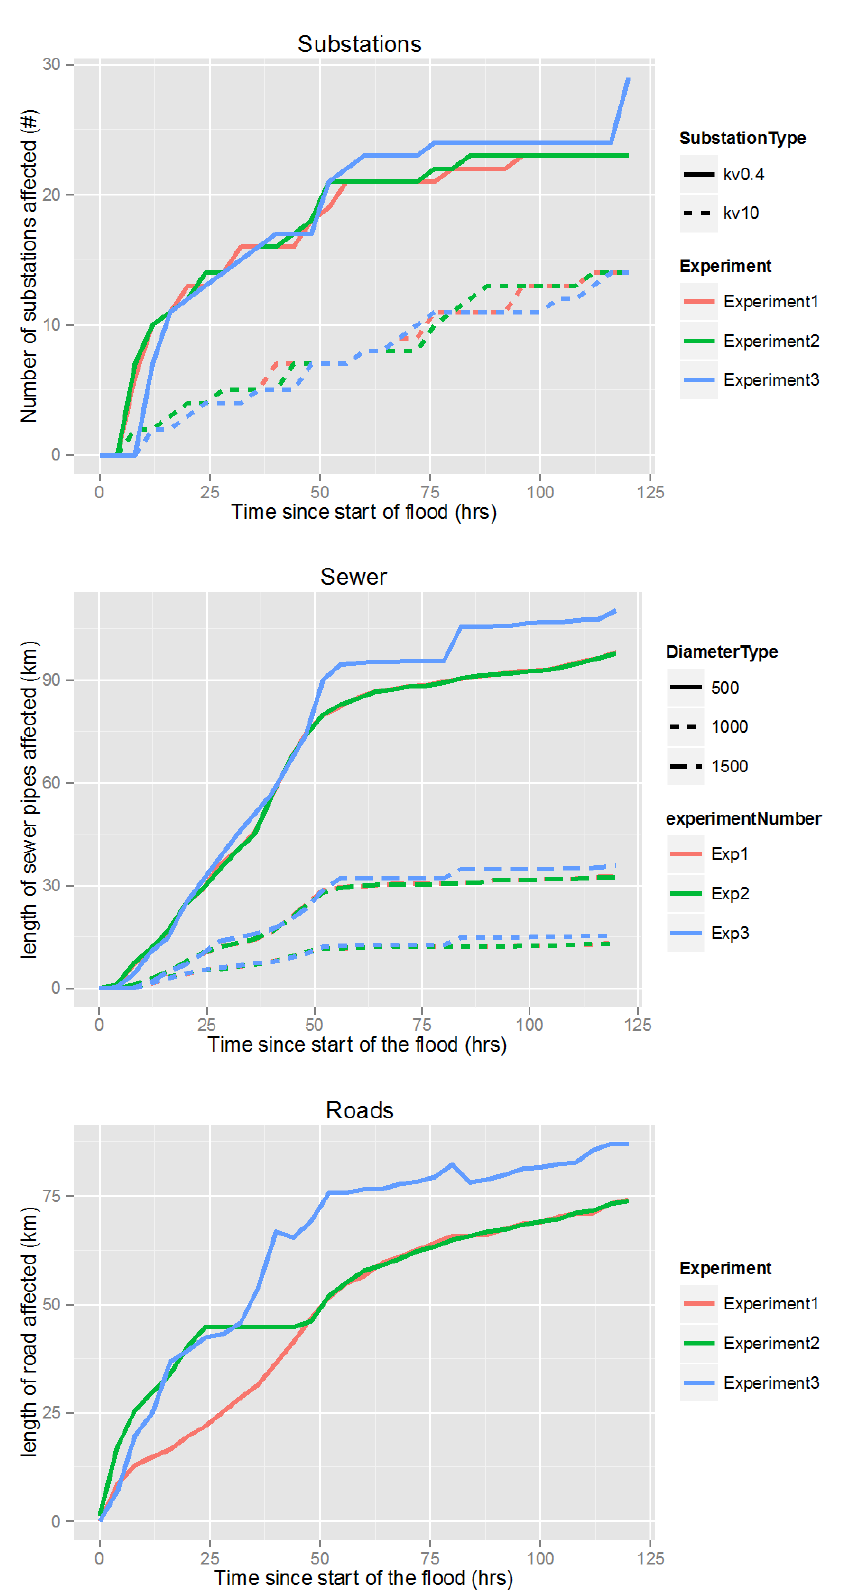
Figure 4. Results from three experiments showing the quantity of assets affected in each